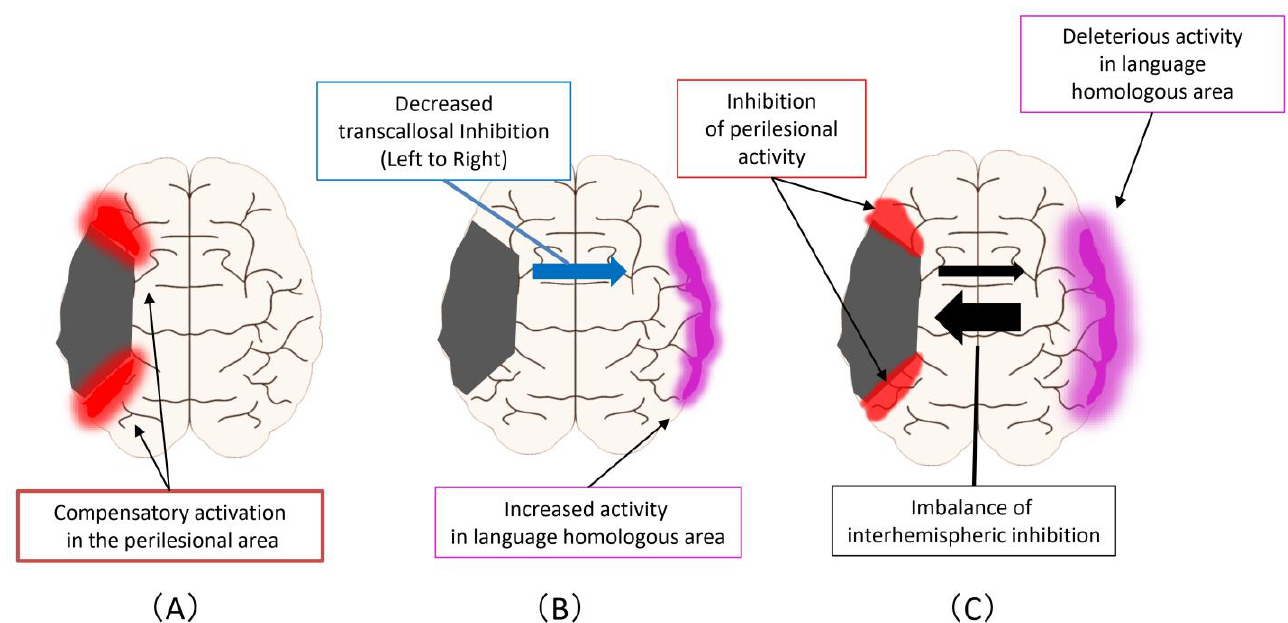
Figure 2. Improvement mechanism for language function in PSA: ( A ) Compensatory activations in the perilesional area, that can occur at any of the acute, subacute, and chronic phases; ( B ) As the next step, an enhancement of activity occurs at homologous areas in the language domain. This reaction is triggered by a decreased transcallosal inhibition from the ipsilesional hemisphere to the contralesional hemisphere that can occur during the acute or subacute phase; ( C ) As the next step, an imbalance of interhemispheric inhibition forms, accompanied by activation of homologous areas in the language region and impediments to functional recovery in the perilesional area.